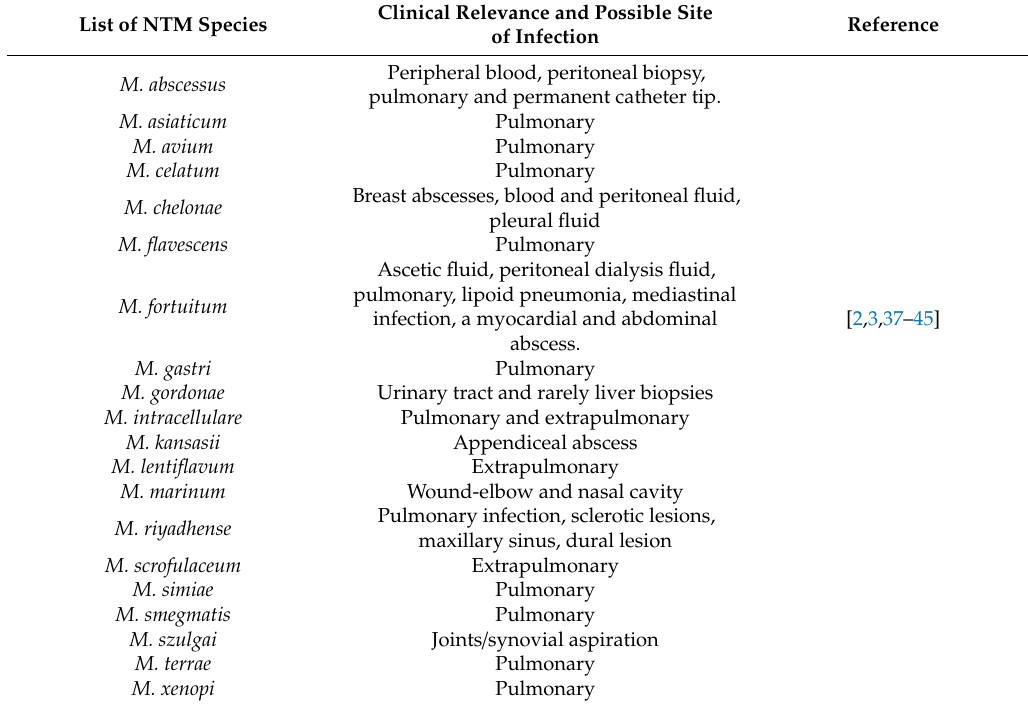
Table 1. Clinical significance and site of infection of nontuberculous mycobacteria